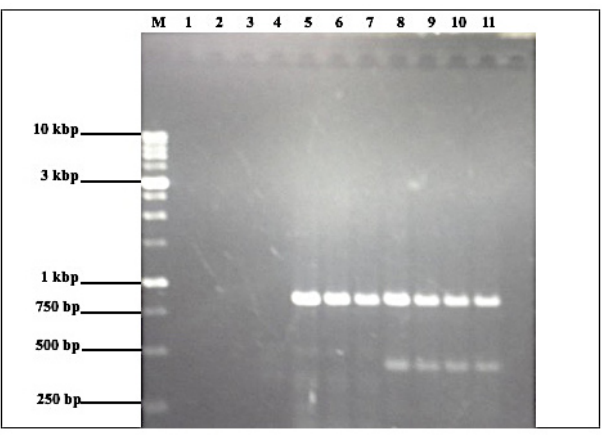
Figure 5. PCR amplification of genomic DNA from C. kaliana (lanes 1 to 4), C. stenochila (lanes 5 to 7) and C. tiomanensis (lanes 8 to 11) using the designed SCAR primer pair (CST_f / CST_r). Lane M represents the 1.0 kb DNA ladder (Promega, USA).